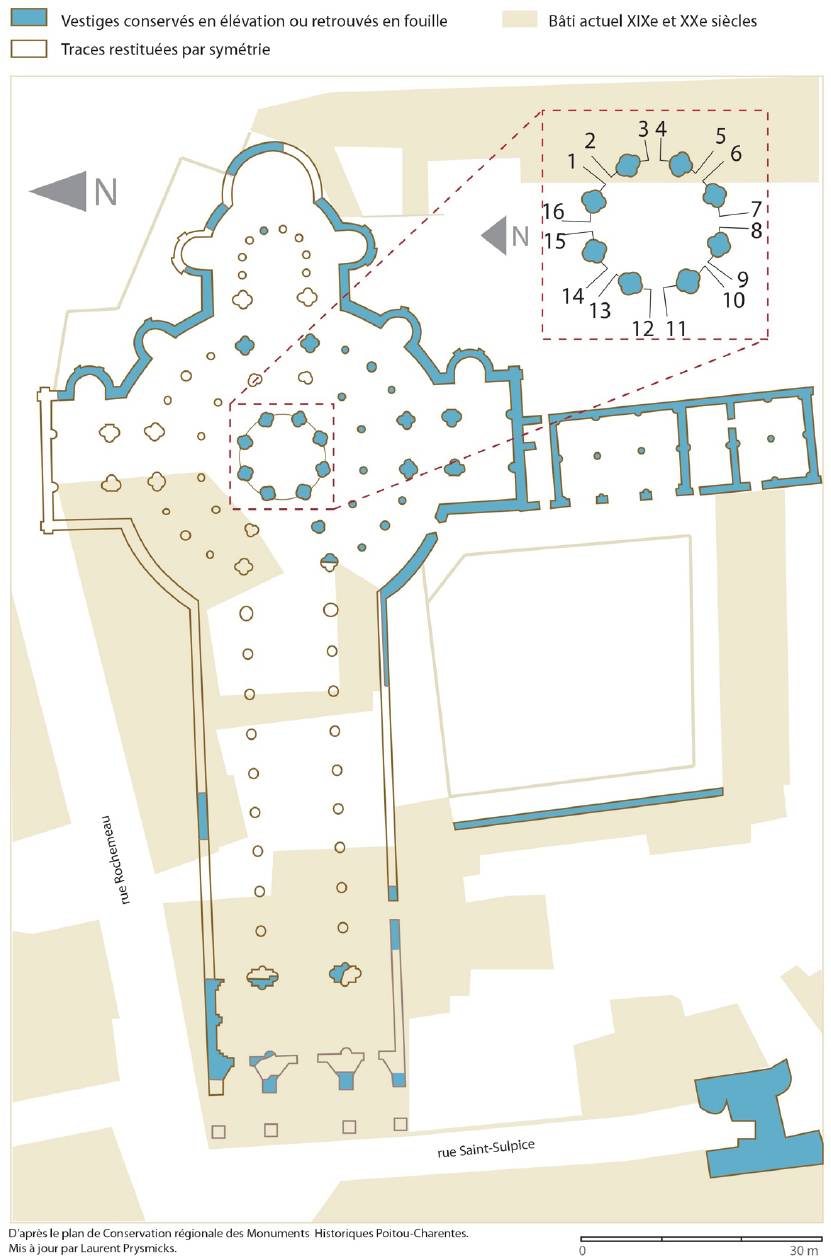
Figure 6. Abbey of Saint-Sauveur de Charroux, plan and reconstruction of the ruined abbey church constructed ca. 1050 – ca. 1096; inset, upper right: detail of the organization of the columns of the rotunda tower (Photo by permission: © Région Nouvelle-Aquitaine, Inventaire général du patrimoine culturel. © Conservation régionale des monuments historiques, Poitiers. Jean Jay, 2011).